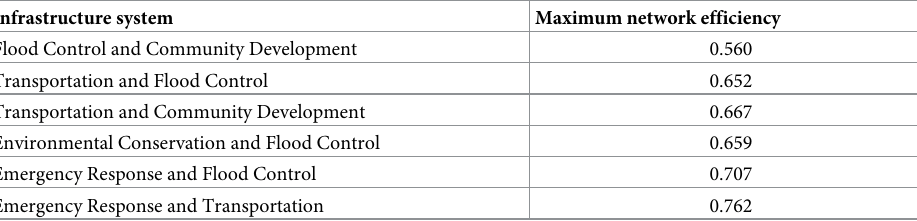
Table 7. Maximum network efficiency across